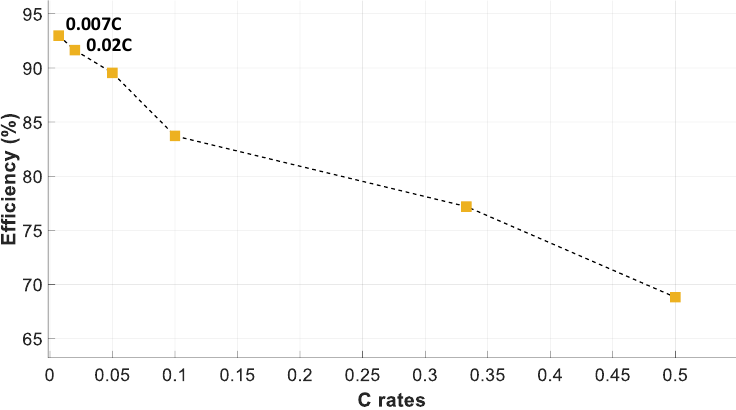
Figure 11. Battery pack efficiency during charge and discharge cycles at different C rates.